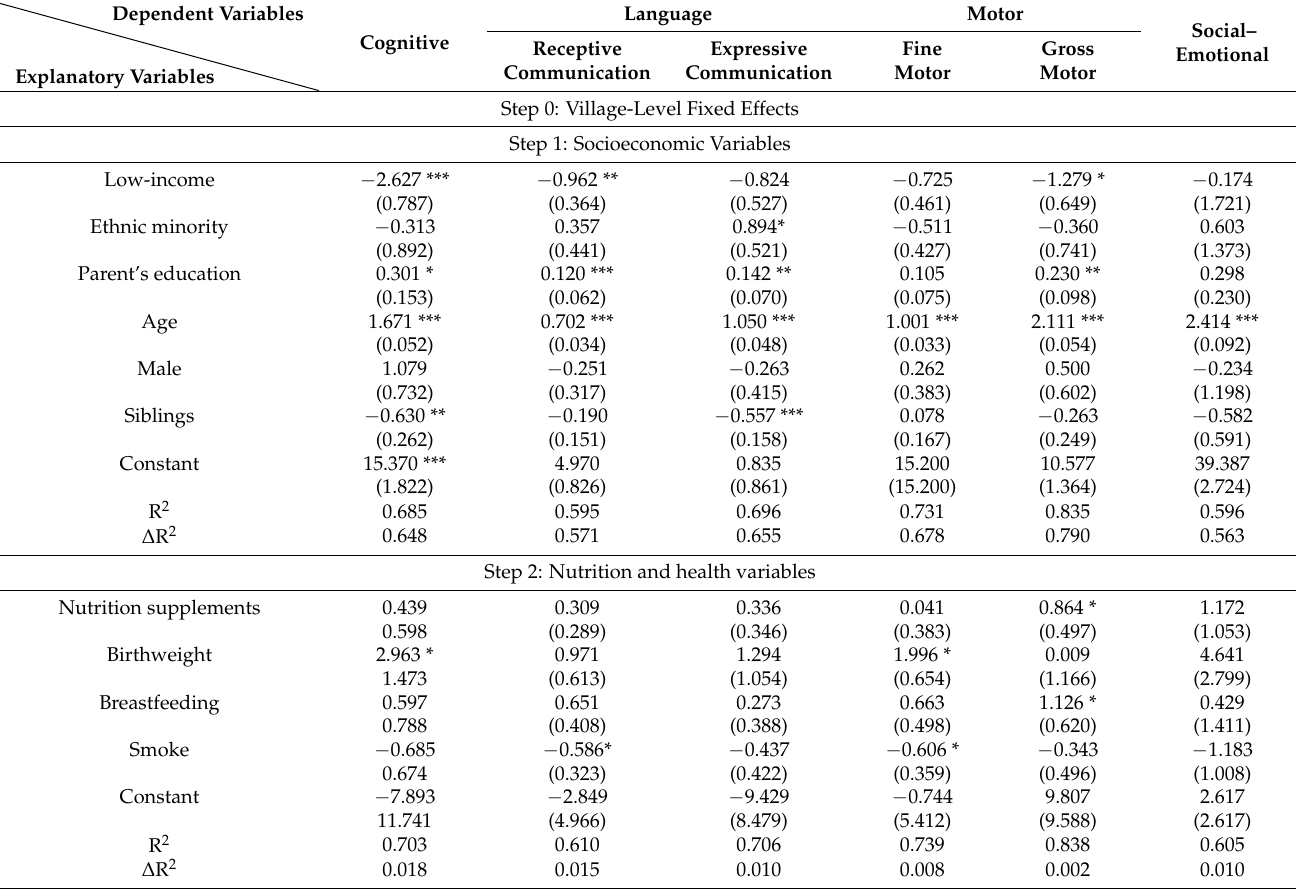
Table 6. Hierarchical regression results (HOME